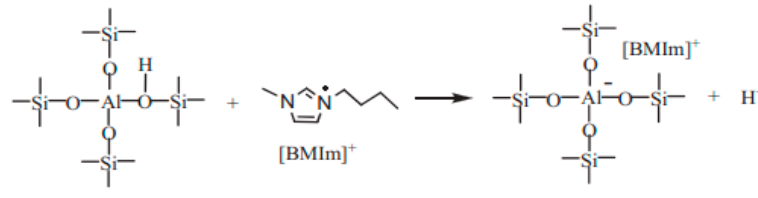
Figure 7. The proposed reaction pathway of zeolite and [BMIm] + .